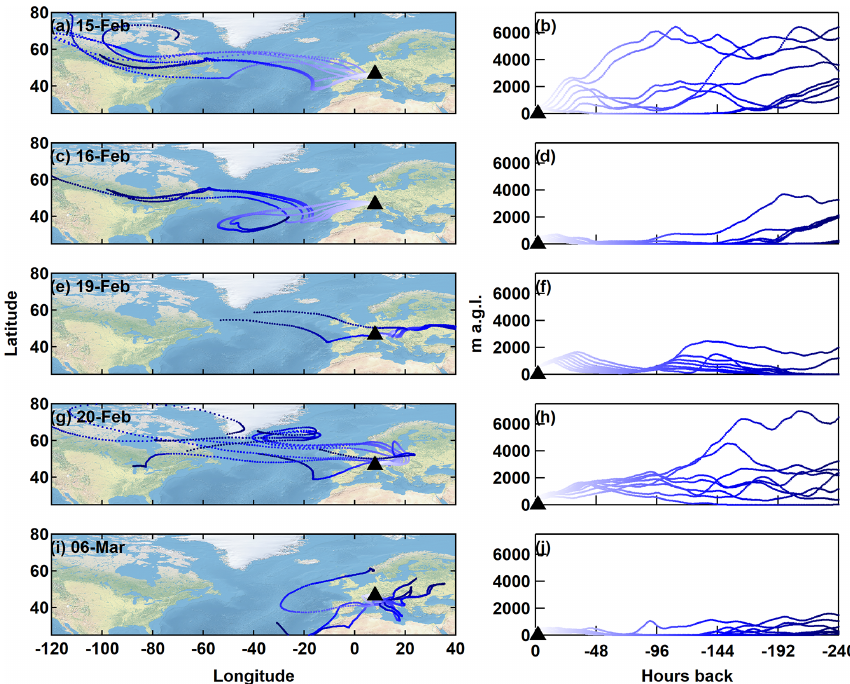
Figure 3. The 10d air mass backward trajectories initiated every 3h during sample collection for northwesterly case days ending at 500m above ground level (a.g.l.). Trajectories are plotted by latitude–longitude (left) and altitude–time (right) profiles for 15 February (a, b) , 16 February (c, d) , 19 February (e, f) , 20 February (g, h) , and 6 March (i, j) . Darker shades of blue represent trajectory points farther back in